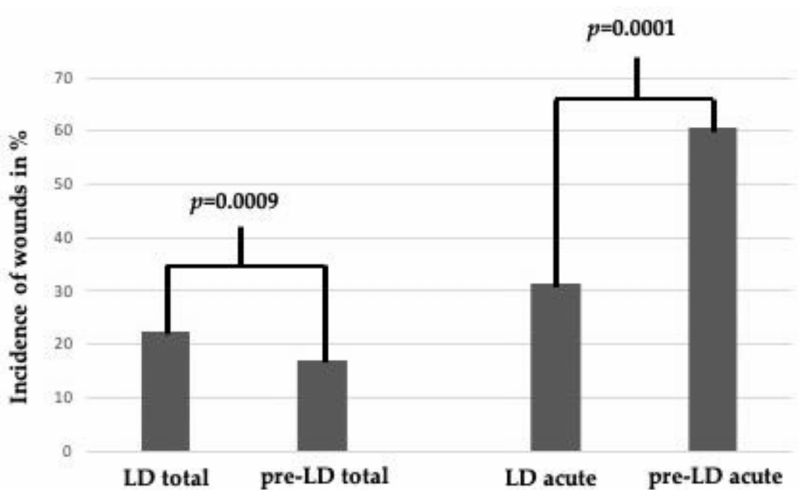
Figure 4. Comparison of wounds in % during LD and the pre-LD periods. “LD total” and “pre-LD total” include the total numbers of injuries, and “LD acute” and “pre-LD acute” include only the acute injuries (fractures, mTBIs, wounds and miscellaneous